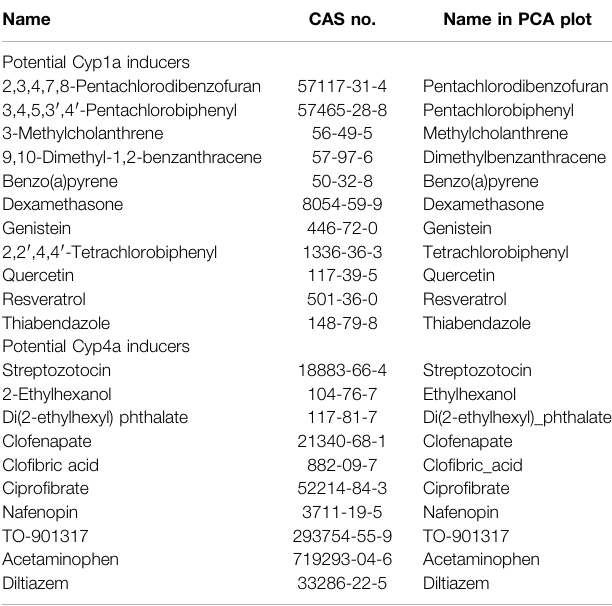
TABLE 4 | List of chemical substances used for external validation of the RAID system. Name CAS no.